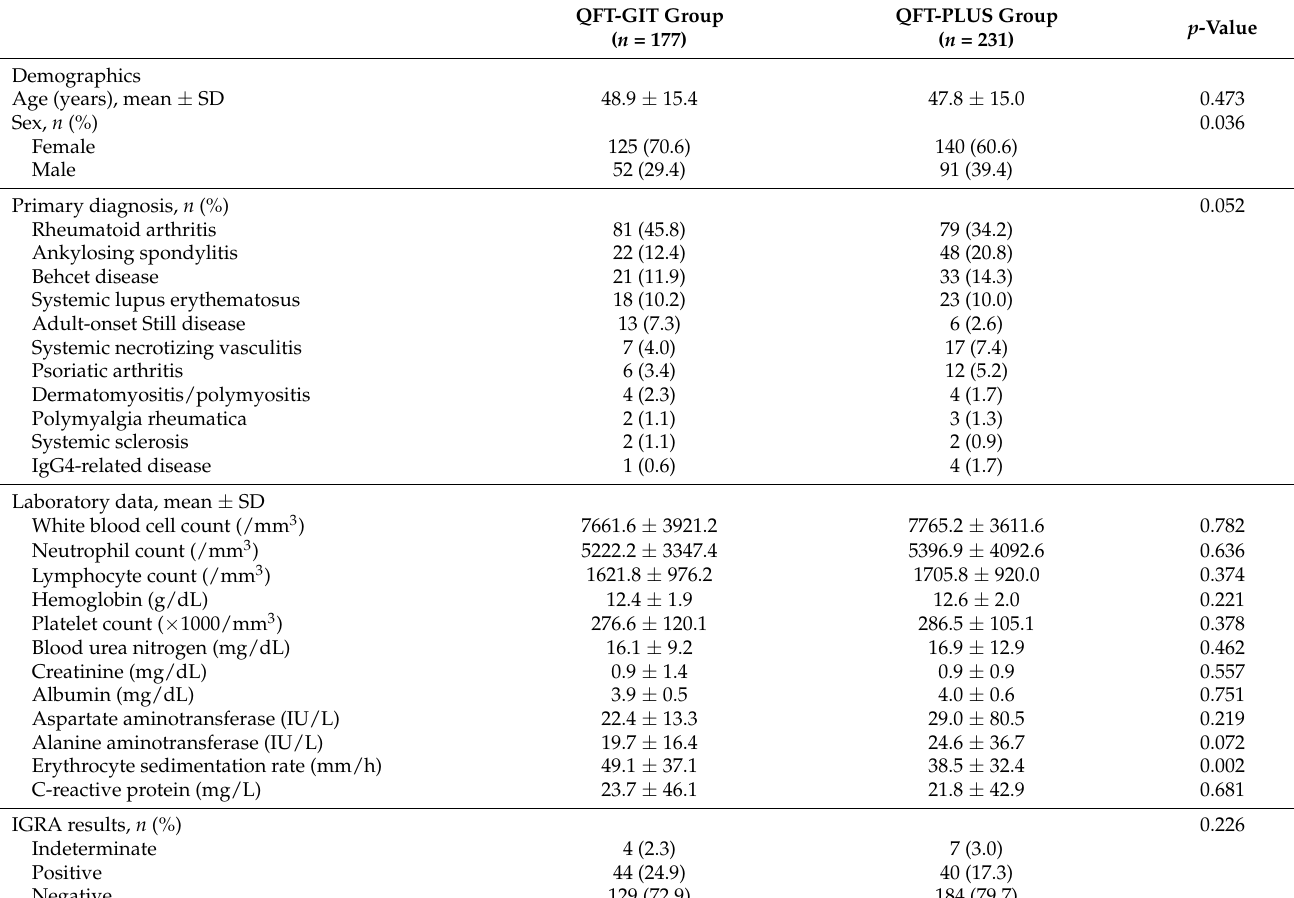
Table 1. Baseline characteristics of patients tested using QFT-GIT and QFT-PLUS. QFT-GIT Group ( n =